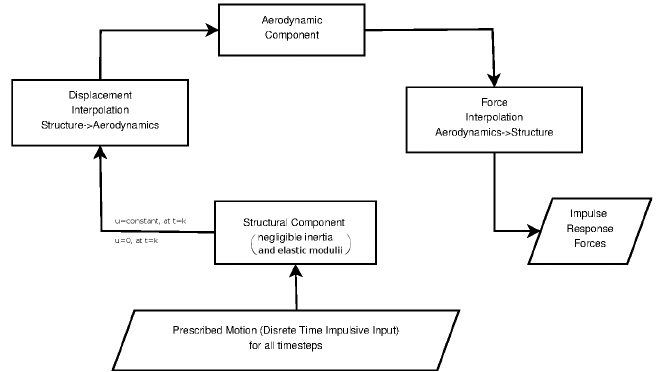
Figure 3. Schematic of the procedure to calculate the necessary aerodynamic impulse